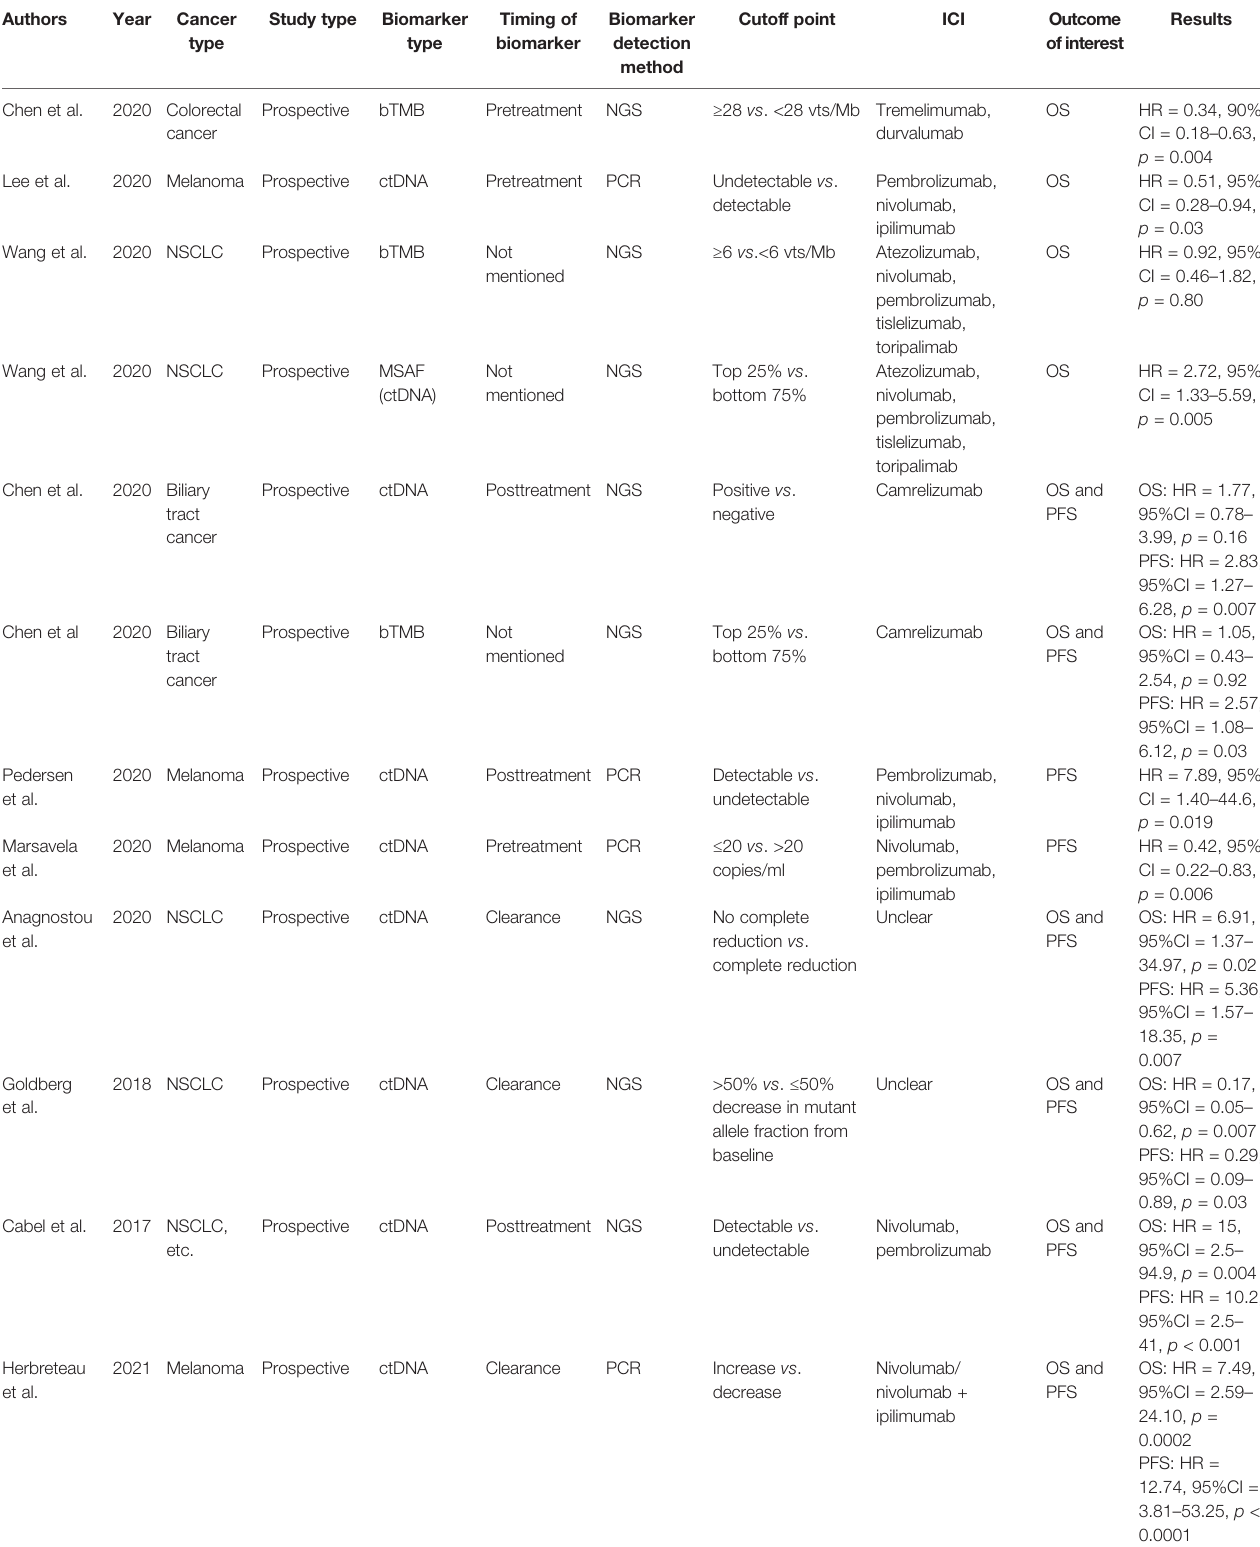
TABLE 1 | Characteristics of the included